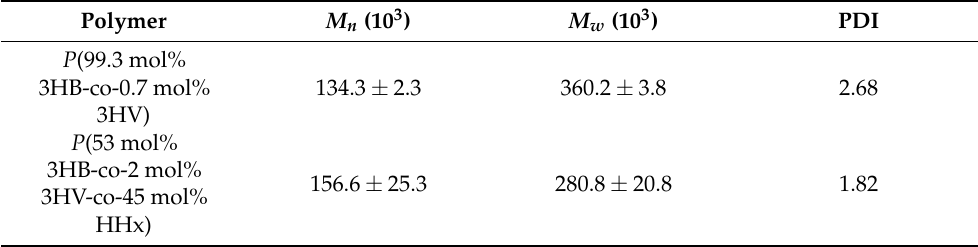
Table 2. Molecular weights and polydispersities of PHA films.